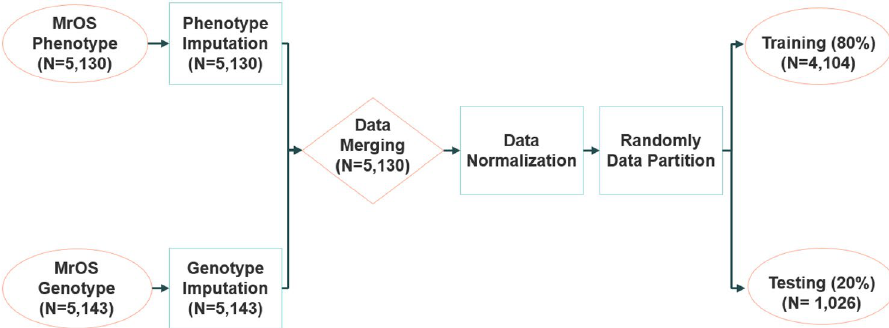
Figure 4. Overview of data process